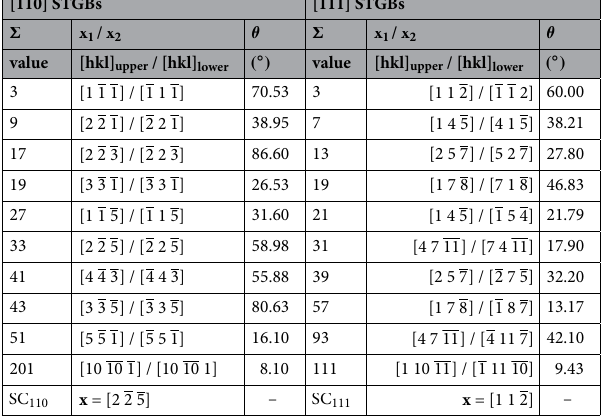
Table 1. For the bicrystal geometry depicted in Fig. 2a, the crystal x -axis for the upper x 1 and lower x 2 crystals. The crystal z -axis is obtained using z = x × y , where the GB plane normal is along the crystal y -axis. The x -axis for single crystal systems with a [110] ( SC 110 ) and [111] ( SC 111 ) loading axis is also